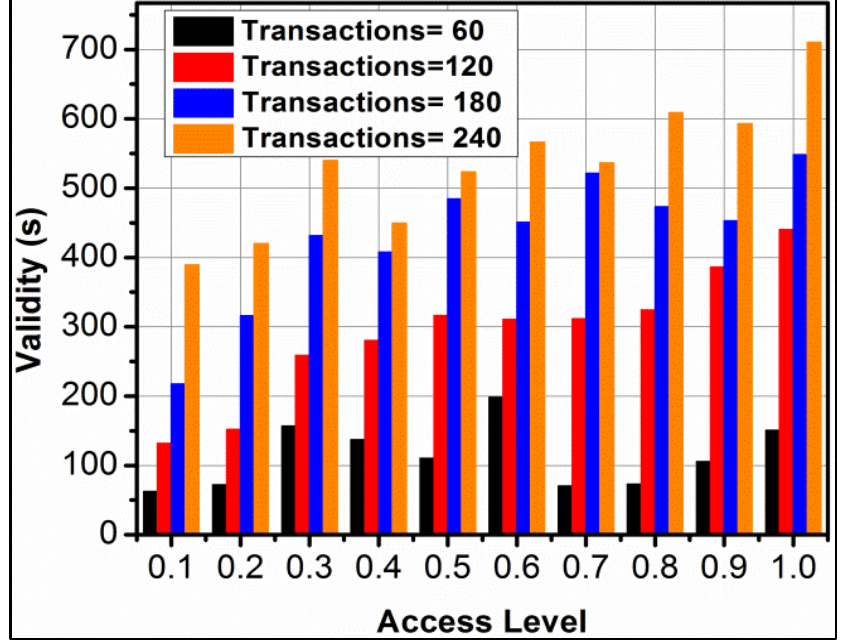
Figure 6. Session validity for different access levels.